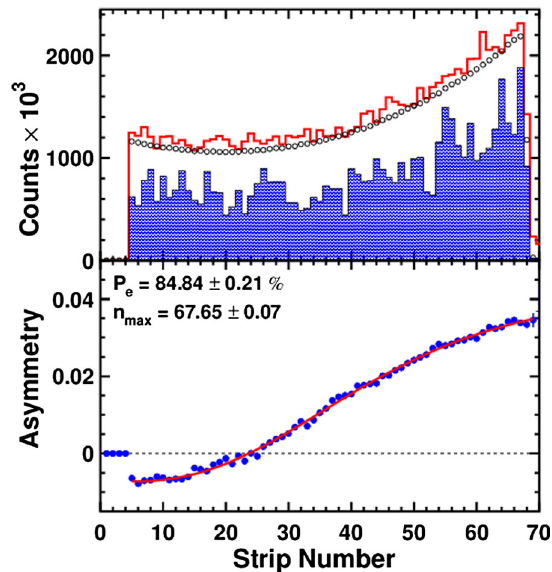
FIG. 5. Direct test of the laser-polarization maximization technique. The correlation between the laser DOCP directly measured after the cavity mirror and the polarization signal extracted from the reflected light. The left panel shows the full range, while the right panel is a zoomed-in version of the region of maximum DOCP.